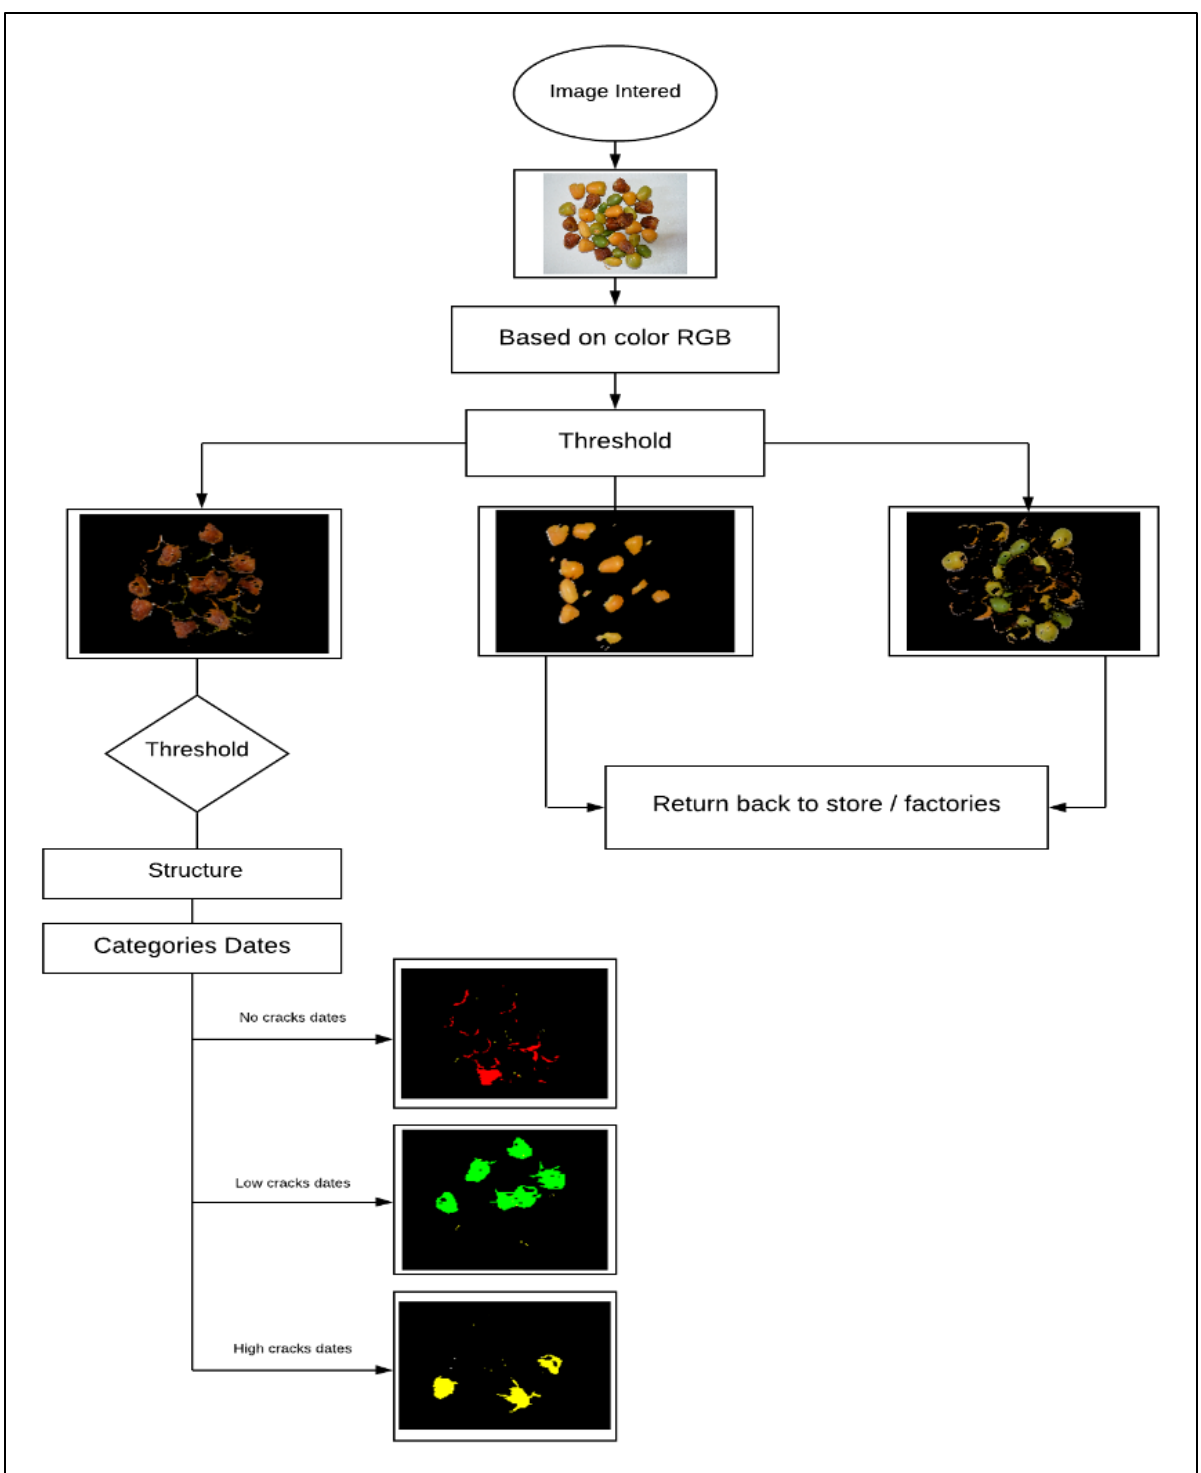
Figure 7. Flow chart describing the classification